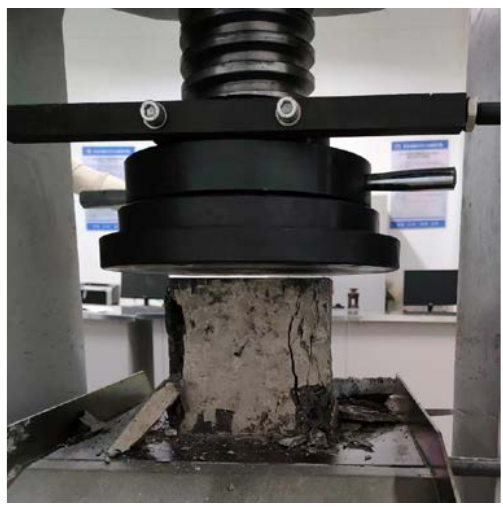
Figure 5. Compression test of concrete specimen.